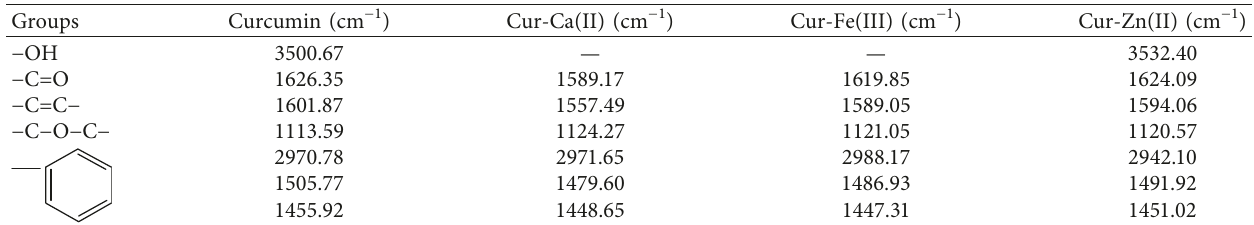
Table 2: Solubility of curcumin metal complex in water solvent at different Tween concentrations. Conc. of Tween 80 (%w/v)